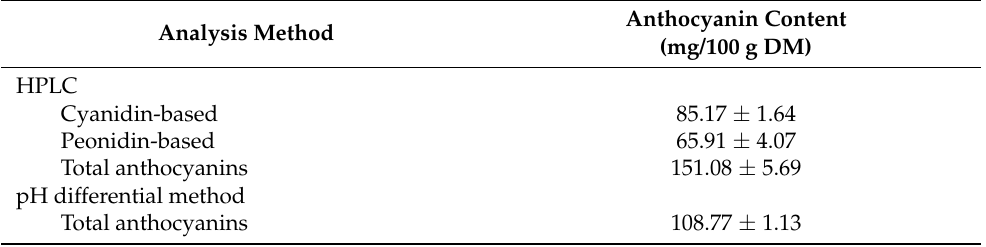
Table 7. Anthocyanins in PSPP using different method of